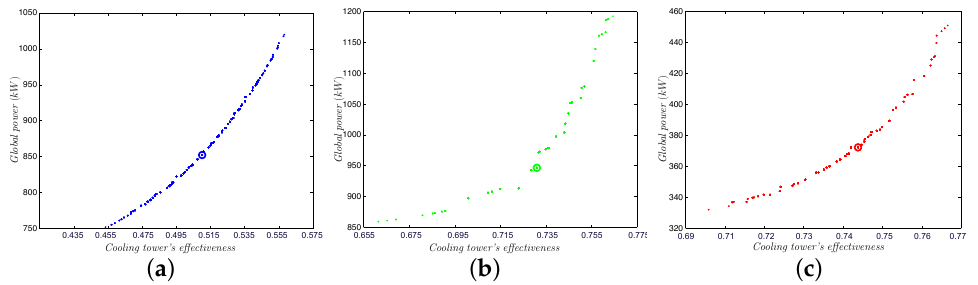
Figure 7. Pareto fronts and selected optimal solutions for 3 of the 35 operating points used in the implementation of the optimization with Micro-GA with stopping criterion after 50 iterations.